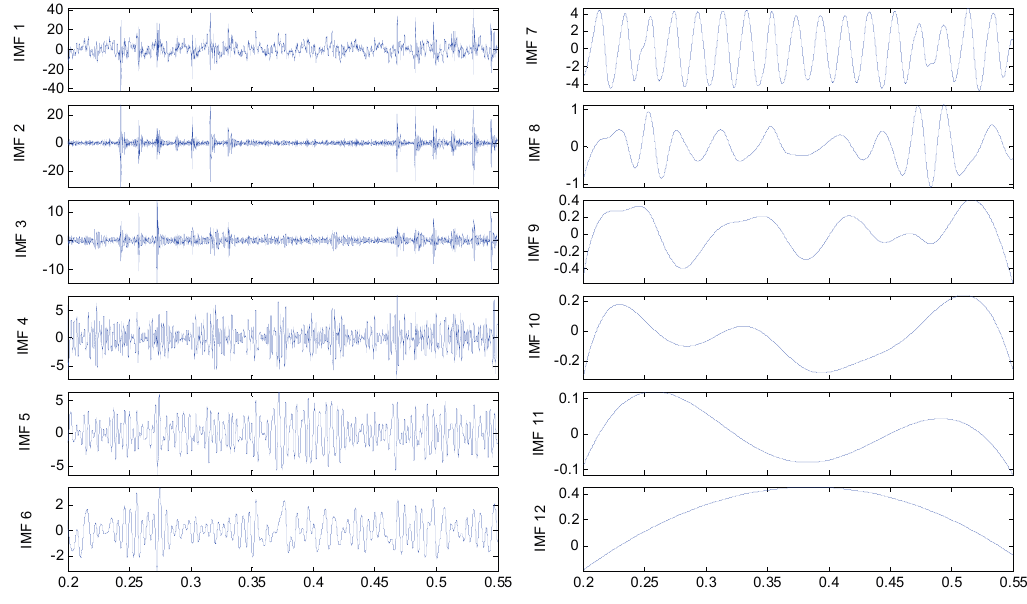
Figure 8. IMFs for the axle bearing vibration signal with pin roller